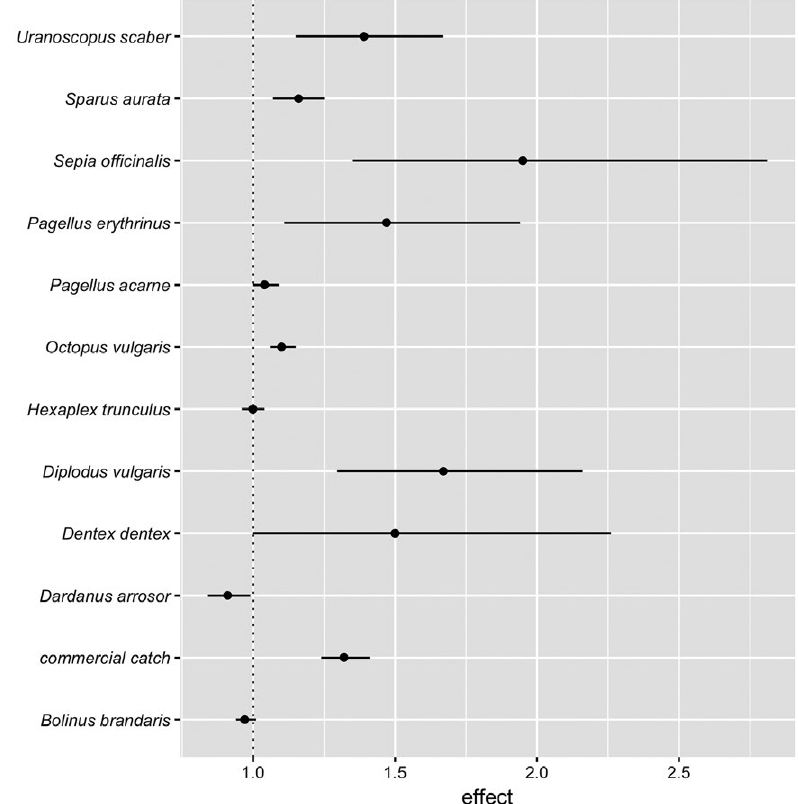
Fig. 2. – Relative measure of effect of the guarding net on the catches of the main commercial species in cuttlefish trammel nets (average and 95% confidence interval). A value of 1 corresponds to no effect (i.e. catches in kg/100 m h of the modified net were not different from those of the standard